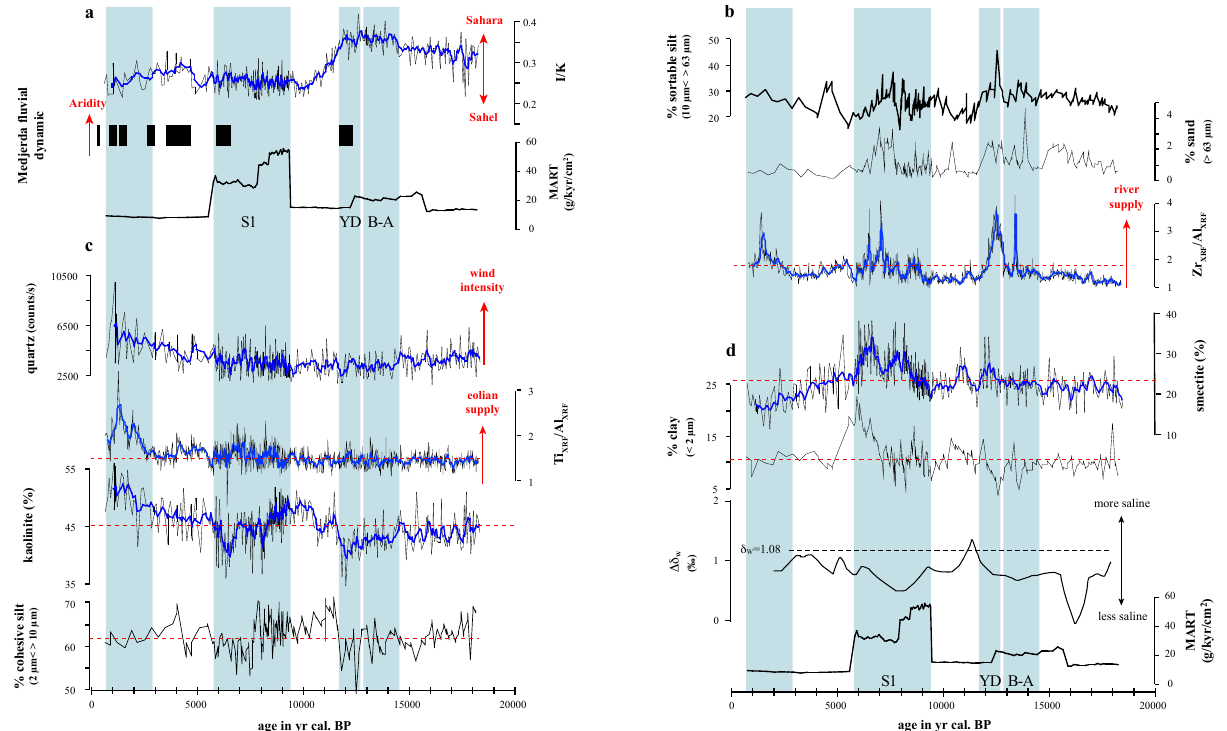
Fig. 5. Comparison of multiproxies data, (a) I / K ratio and its interpretation on particles provenance, increased aridity as indicated by Med- Bout-Roumazeilles et al. Tracking atmospheric and riverine - Figure 5 jerda fluvial dynamic (Tunisia) modified from Zielhofer et al. (2008) and MART (gkyr − 1 cm − 2 ) from Fig. 2, (b) grain size compared with Zr XRF / Al XRF ratio; (c) quartz content (counts/s), Ti XRF / Al XRF ratio, kaolinite (%) and % of cohesive-silt, (d) Smectite ()%, characterizing the sapropel S1, % of clay, 1δ W (‰) values calculated using SSTs derived alkenones (Essallami et al., 2007). and MART (gkyr − 1 cm − 2 ) from Fig.